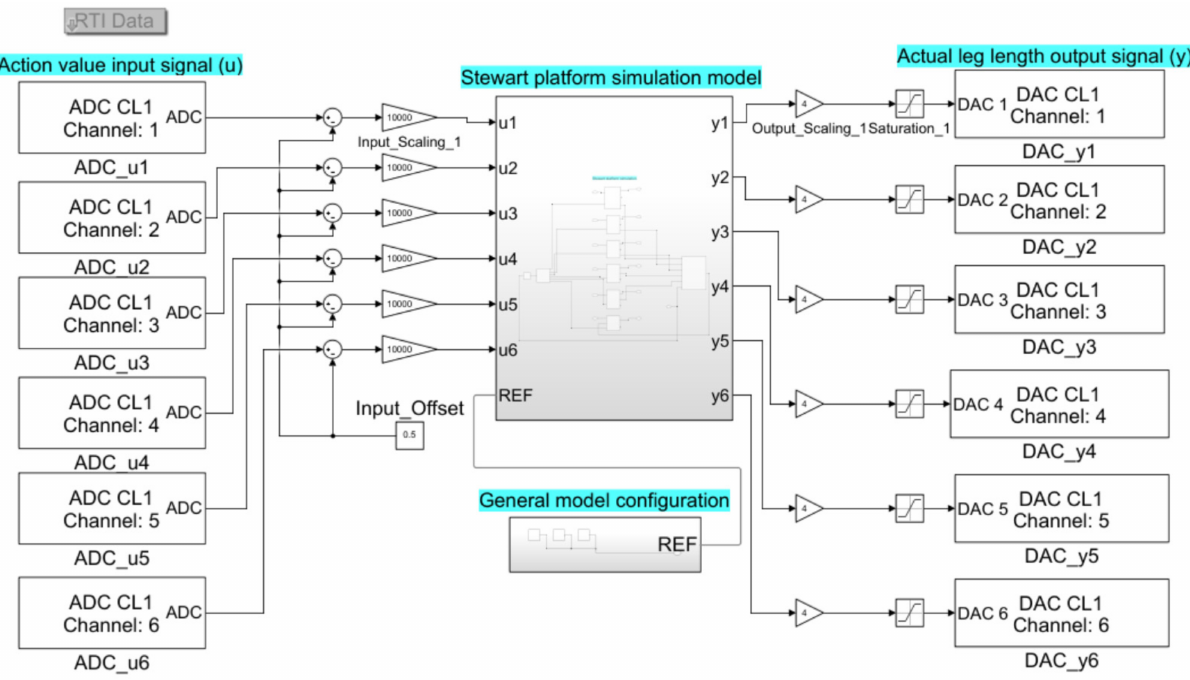
Figure 16. Simulink block diagram of the Stewart platform for the HiL